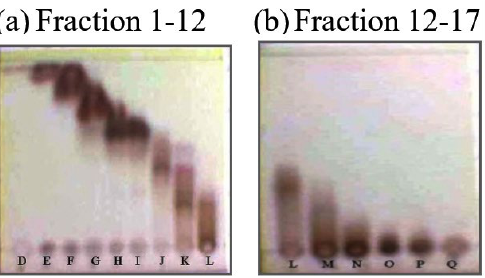
Fig. 1. Profiles of TLC chromatogram of crude aseton extract fractination; (a) Fraction 1-12: eluent n-hexane : ethyl acetate 80%, (b) Fraction 12-17 : eluent n-hexane : acetone